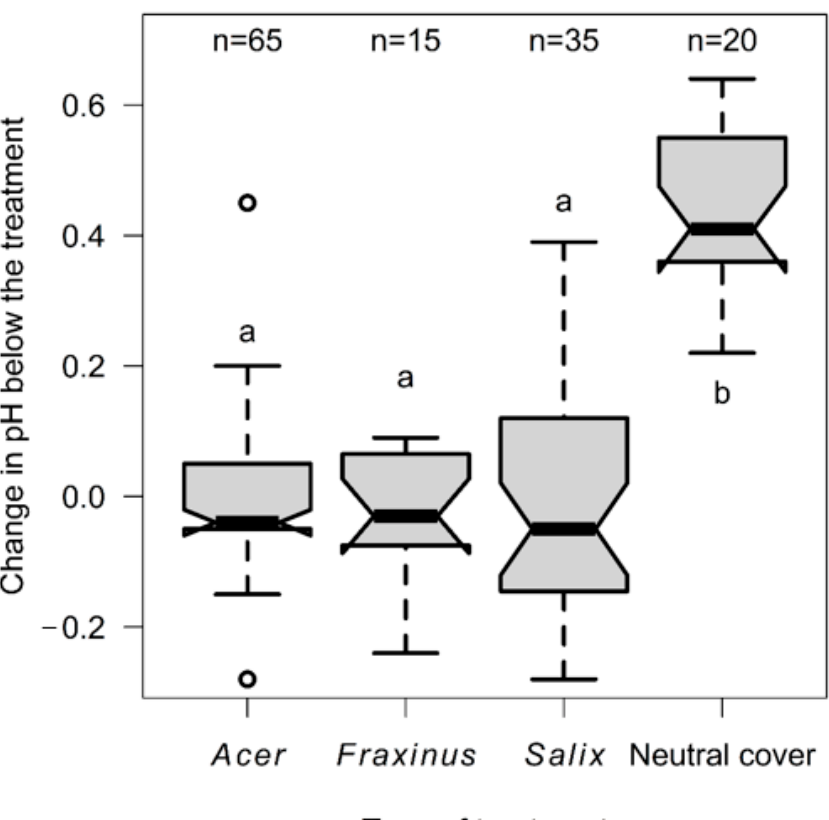
Figure 3. The difference in the change in pH (in comparison to control samples) below bryophytes and the experimental neutral cover with different labels for significantly different groups ( α = 0.05; p -values for pairwise comparisons of neutral cover with other groups were always p < 0.001). Different letters a, b indicate groups with significantly different pH in pairwise comparison. ◦ rep-resents